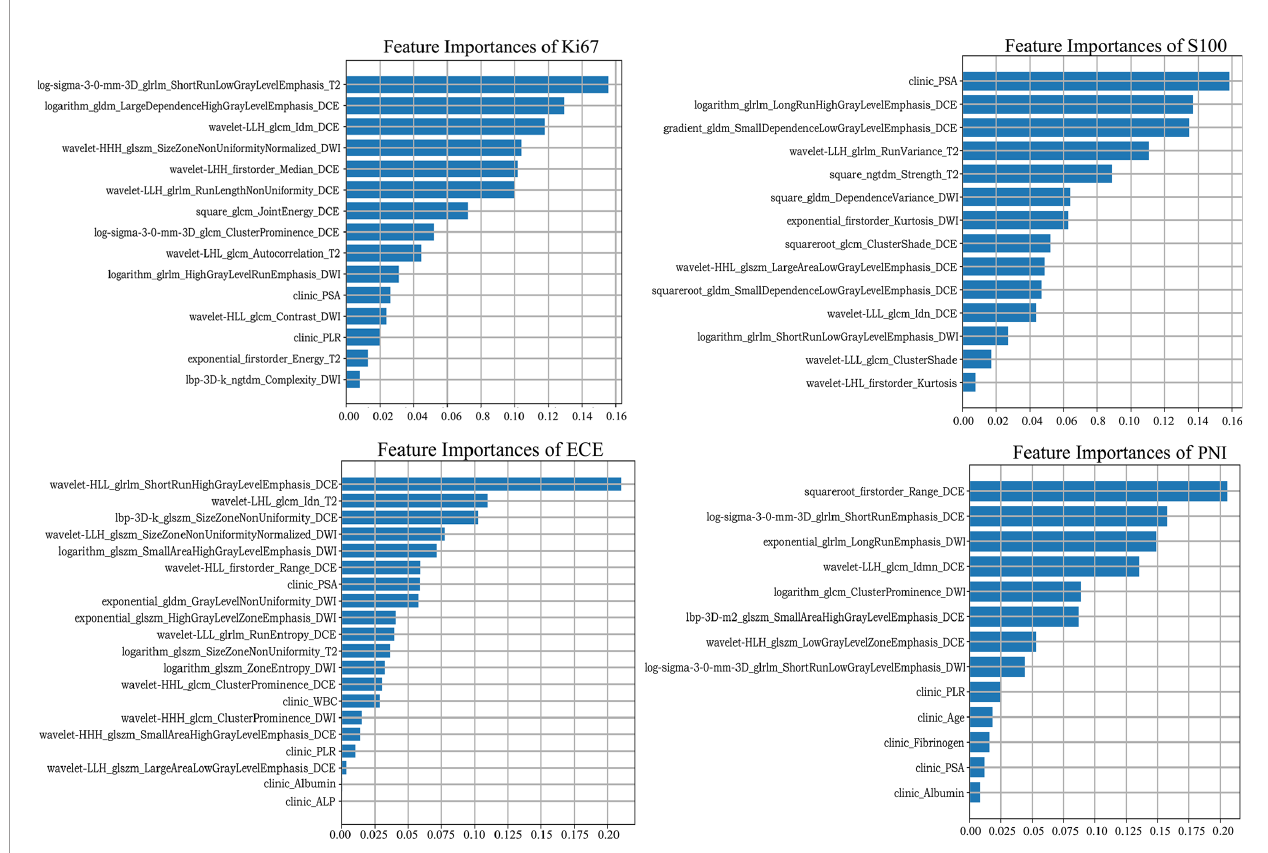
FIGURE 5 | The inbuilt feature importance in each combined